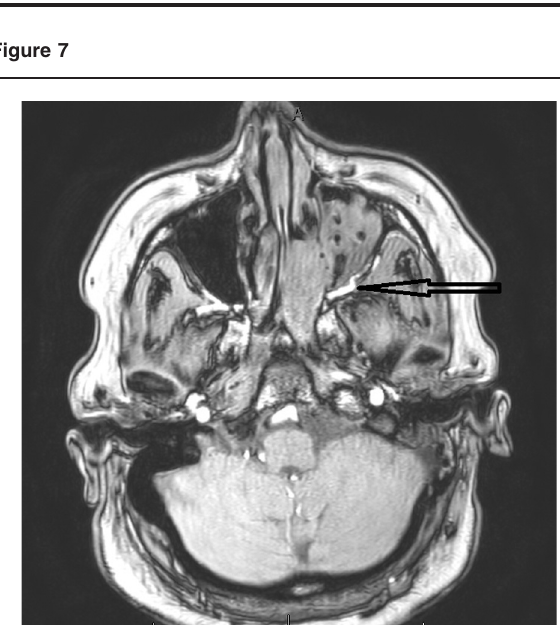
Axial source image MRI postintravenous contrast showing the feed- ing vessel (arrow) from the left internal maxillary artery.